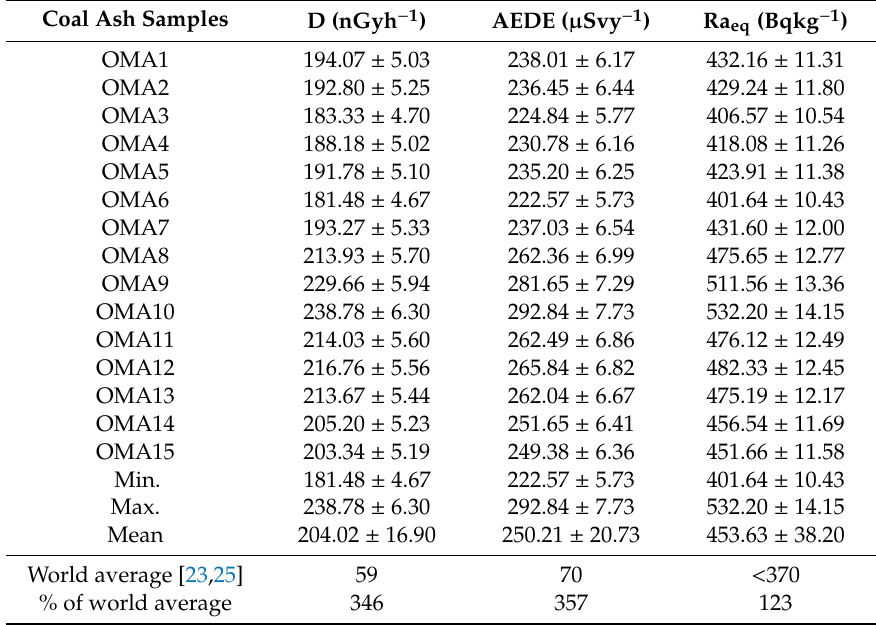
Table 8. Radiological hazard indices for radionuclides in Omelewu simulant coal ash samples. Coal Ash